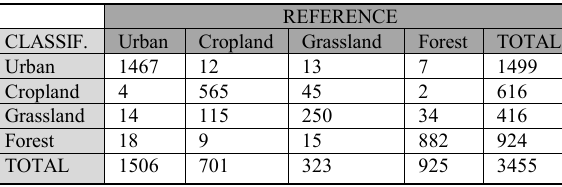
Table 3: Confusion matrix for the classification of the aerial image combined with the RapidEye image.